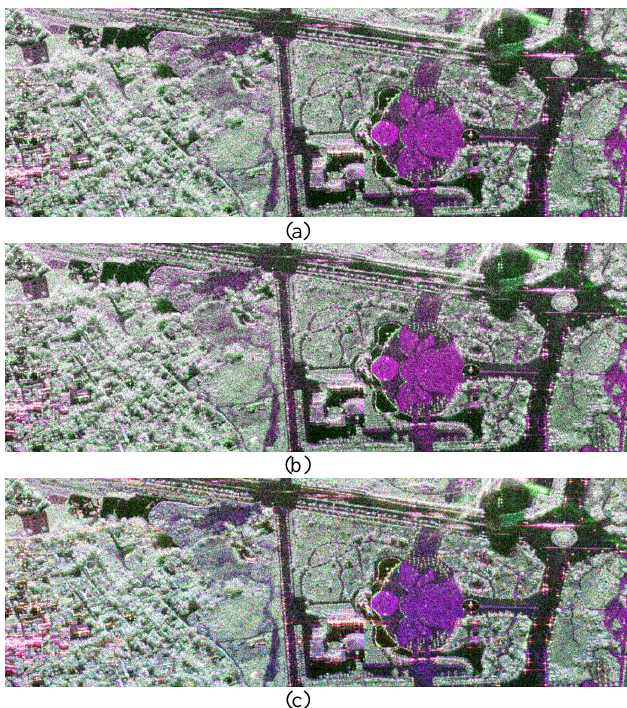
Figure 4. RGB image in Pauli basis before and after simulated data calibration, set k =0.5. (a) RGB image before calibration. (b) Calibrated image using the original method. (c) Calibrated image using the modified